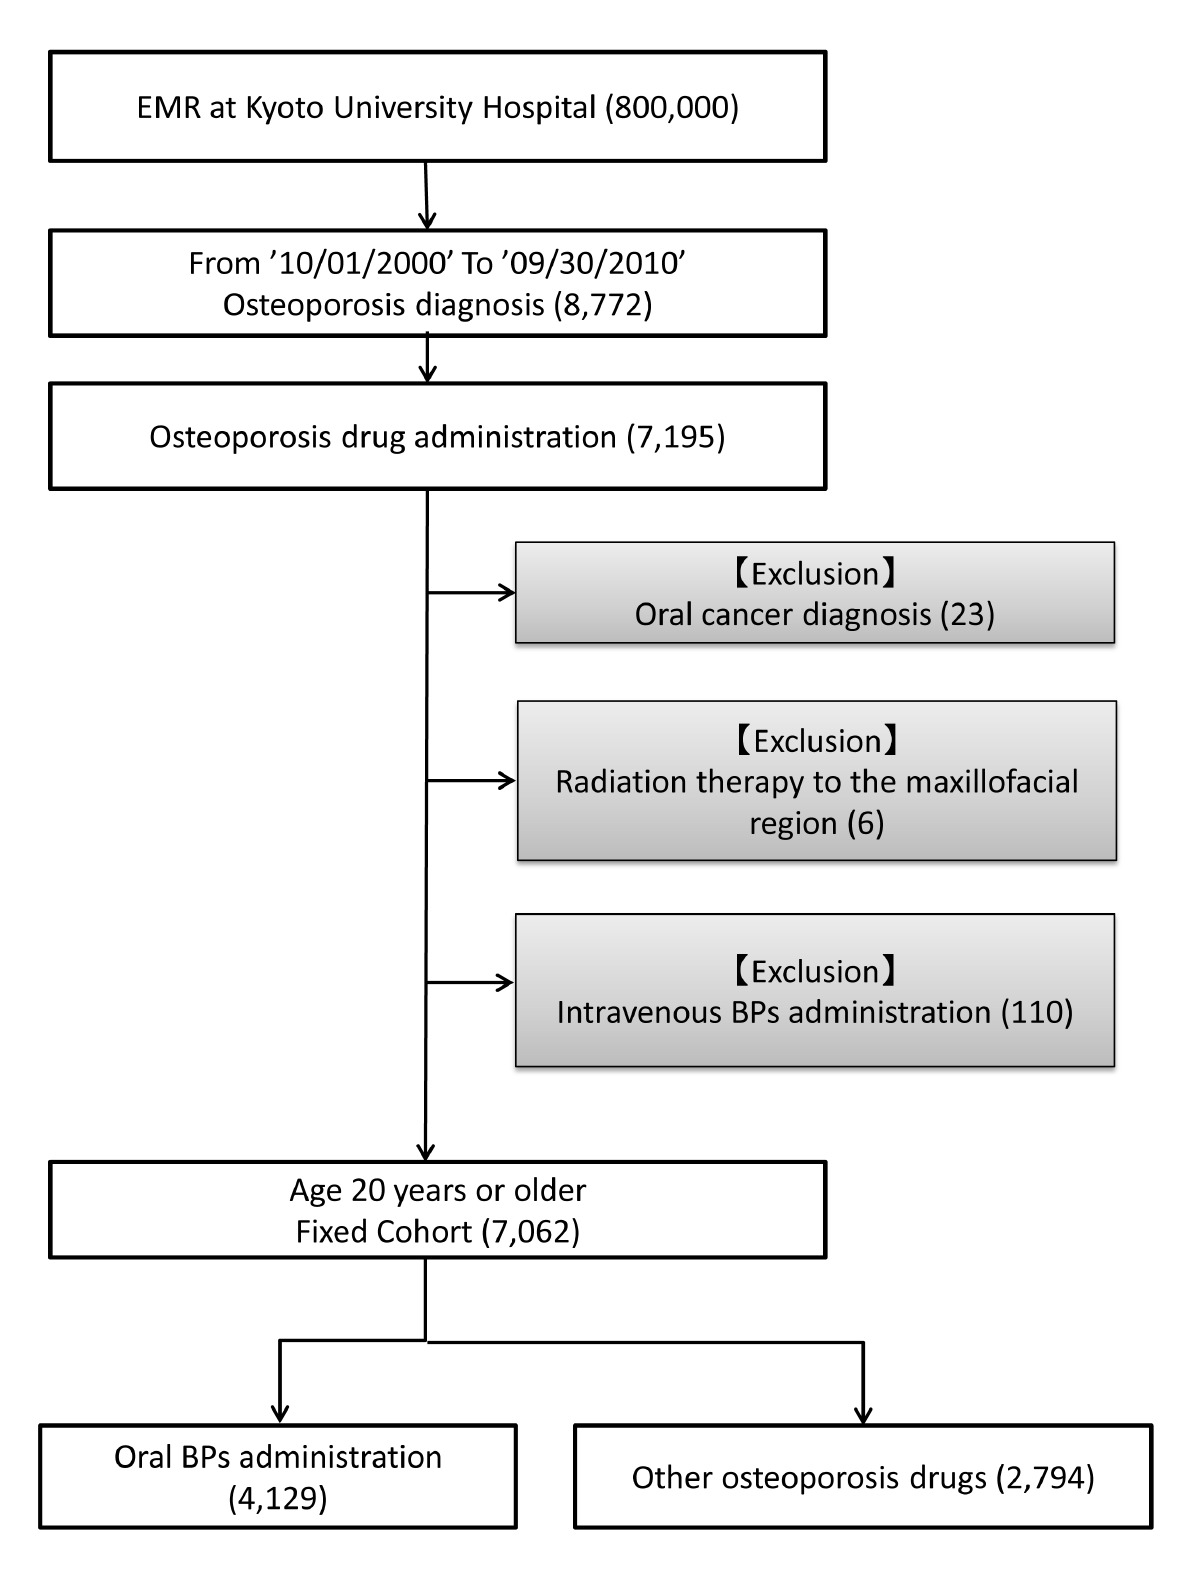
Figure 1. Patient flowchart. BPs = Bisphosphonates; EMR = Electronic Medical Records. doi: 10.1371/journal.pone.0079376.g001 PLOS ONE |